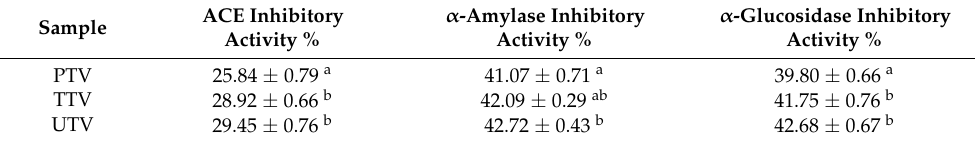
Table 5. ACE inhibitor and antidiabetic inhibitory activities of PTV, TTV and